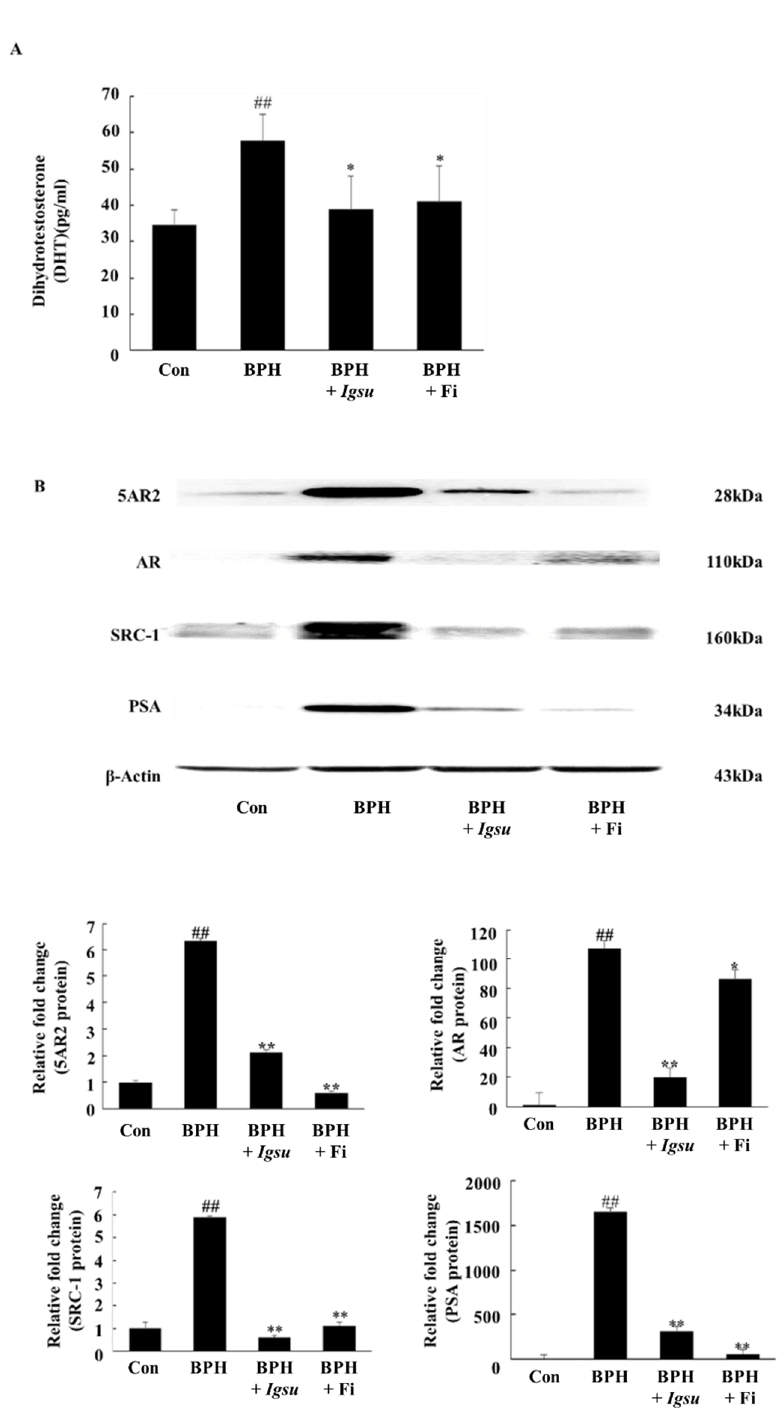
Figure 5. Expression of androgen receptor (AR) signaling-related factors in prostate tissue following administration of Morus root (MR) in BPH. ( A ) Concentration of dihydrotestosterone (DHT) in the prostate tissues. ( B ) Expression of 5-alpha-reductase-type 2 (5AR2), AR, steroid receptor coactivator (SRC)-1, and prostate-specific antigen (PSA) proteins in prostate tissues. Con, normal control group; BPH, TP (3 mg / kg / day) / corn oil injection; BPH + Igsu , Igsu -treated BPH group; BPH + Fi, Fi-treated BPH group. Data are presented as the mean ± SEM ( n = 8). Significant di ff erences at ## p < 0.01 compared with the Con group. Significant di ff erences at * p < 0.05, ** p < 0.01 compared with the BPH group.